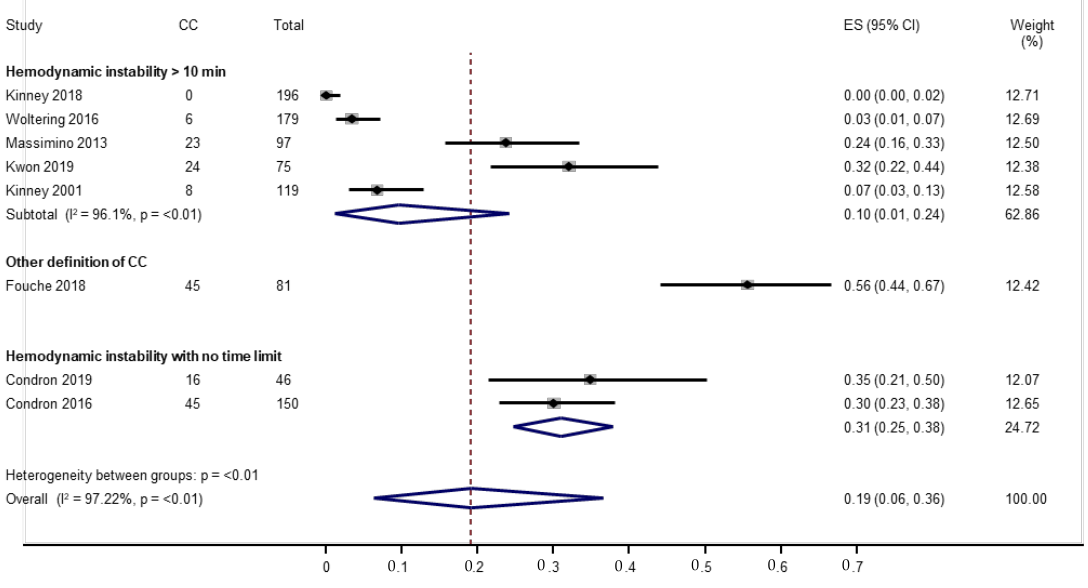
Figure 1. Forest plot evaluating incidence of carcinoid crisis [20 – 27].